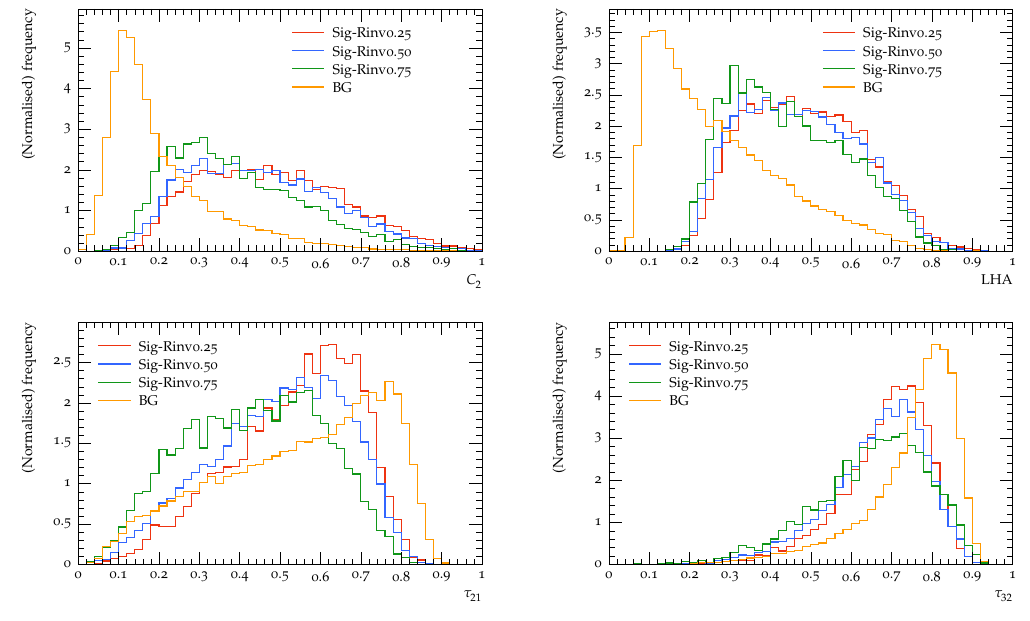
Figure 7: Comparisons of C (bottom right) between three different signals corresponding to R 0.50 and 0.75, and the background for α